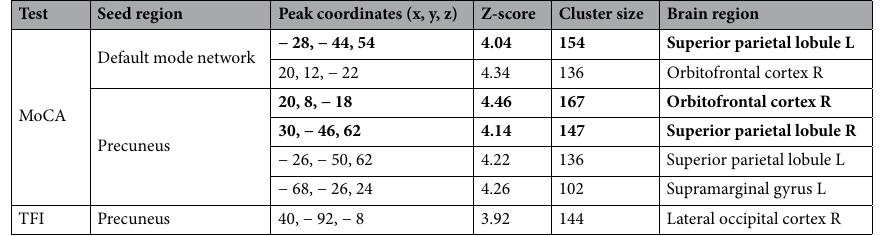
Table 1. Resulting clusters of multiple regression within the tinnitus group controlled for age and sex (significant clusters that survive Bonferroni correction are displayed in bold).